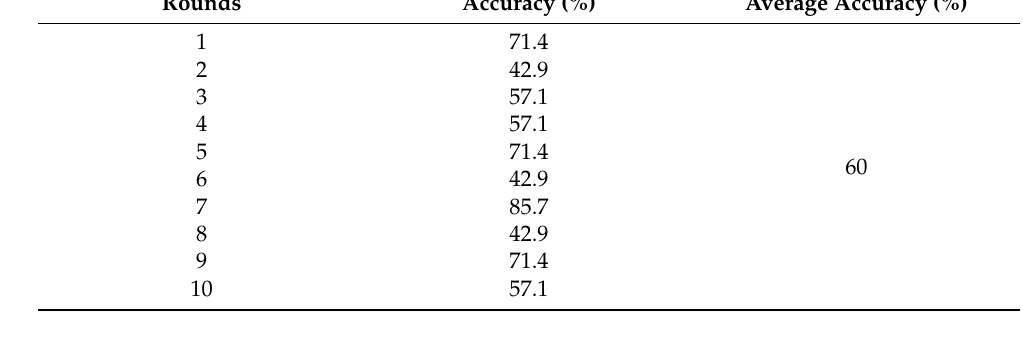
7 of 12 Table 2. The recognition accuracies under a one-year classification scale. Rounds